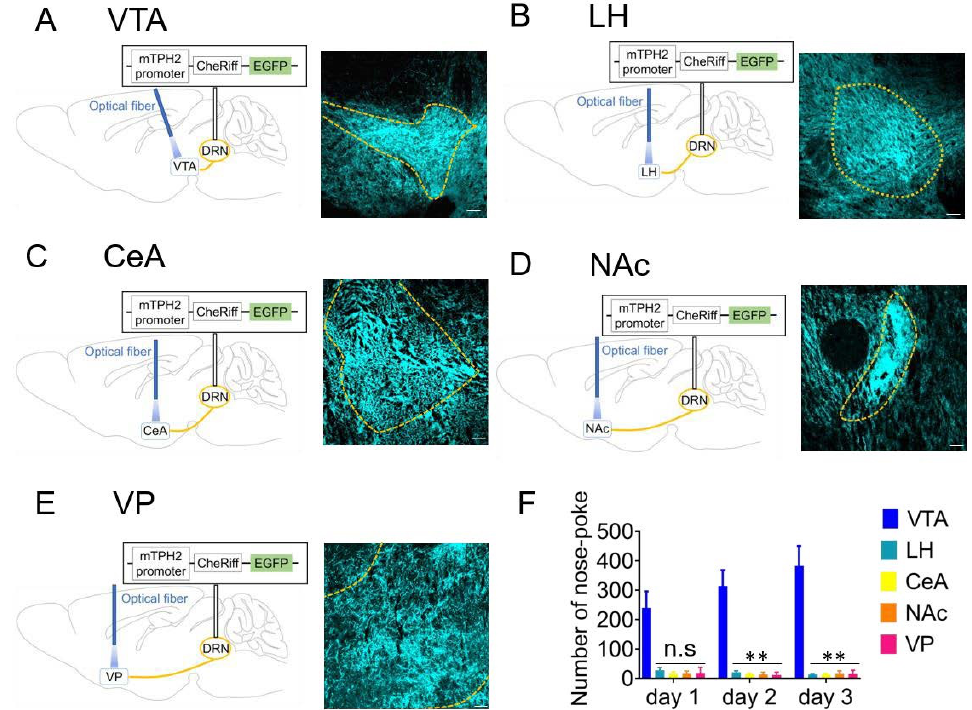
Figure 2. Optogenetic activation of 5-HT neuron terminals in ventral tegmental area (VTA) is responsible for inducing self-stimulation behavior. ( A – E ) (left) Schemas showing the sites of adeno-associated virus injection and fiber implantation. (right) Four weeks after mTPH2::CheRiff injection in the dorsal raphe nucleus (DRN), coronal sections containing the ventral tegmental area (VTA) ( A ), lateral hypothalamus (LH) ( B ), central amygdala (CeA) ( C ), nucleus accumbens (NAc) ( D ), and ventral pallidum (VP) ( E ) were prepared and stained by anti-green fluorescent protein (GFP) antibodies. Stained sections were imaged using confocal microscopy. Scale bars = 100 μm. ( F ) After injection of mTPH2::CheRiff, the number of nose-poke responses in the operant chamber was measured. Blue light was unilaterally delivered when mice performed nose-poke responses. Data represent mean + SEM of the number of nose-pokes during a 30 min session. VTA; n = 8 mice, LH; n = 7 mice, CeA; n = 8 mice, NAc; n = 8 mice, VP; n = 7 mice. ** p < 0.01 vs. VTA, n .s.: not significant (Day